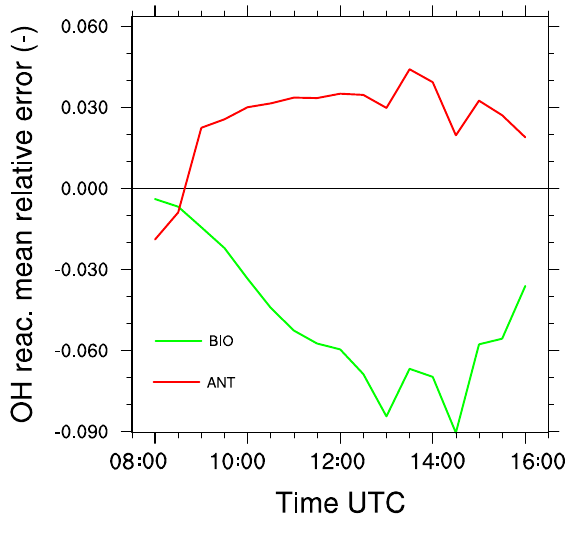
Figure 10. Mean relative error E R neglecting turbulent motions for the biogenic case (green) and the anthropogenic case